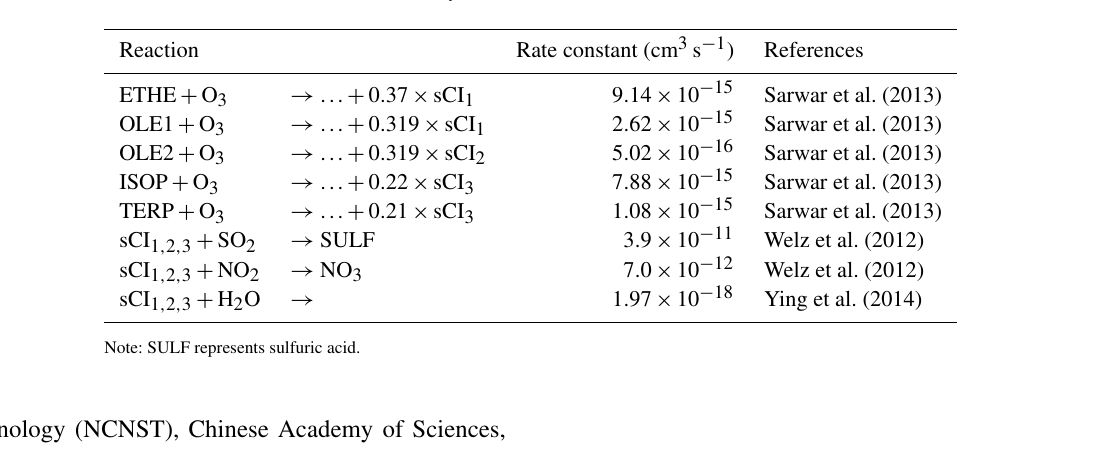
Table 2. Reactions and rate constants related to sCI